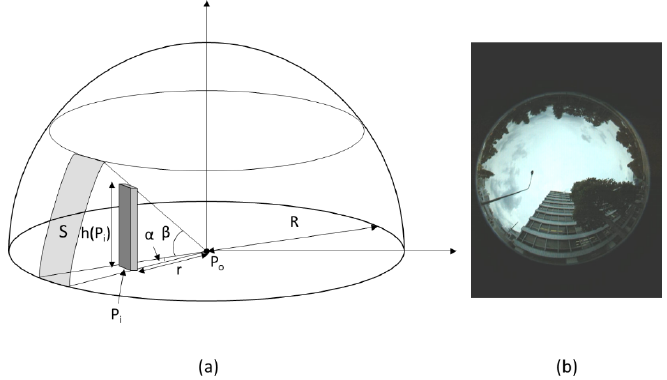
Figure 2. ( a ) Illustration of the algorithm to estimate SVF ; ( b ) fisheye photograph showing a building and a tree overlapped.